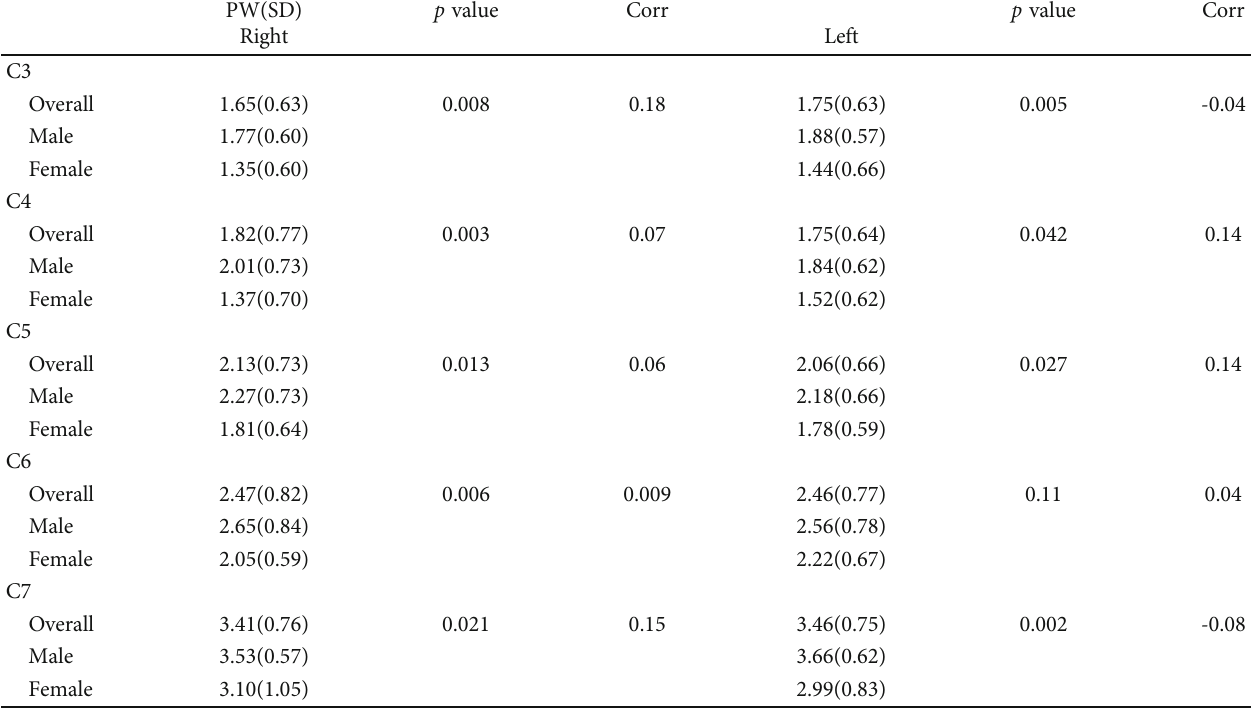
Table 1: Showing pedicle width of 70 participants.